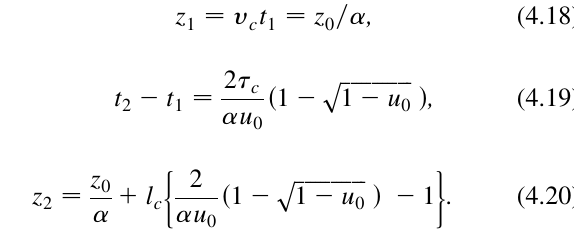
when the traveling 0